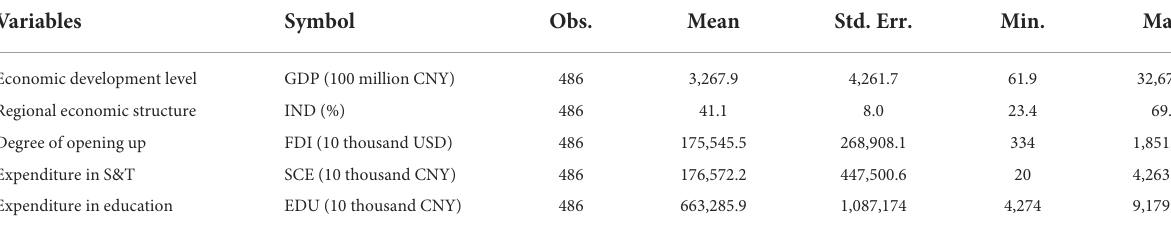
TABLE 3 Descriptive statistical results of panel data of influencing